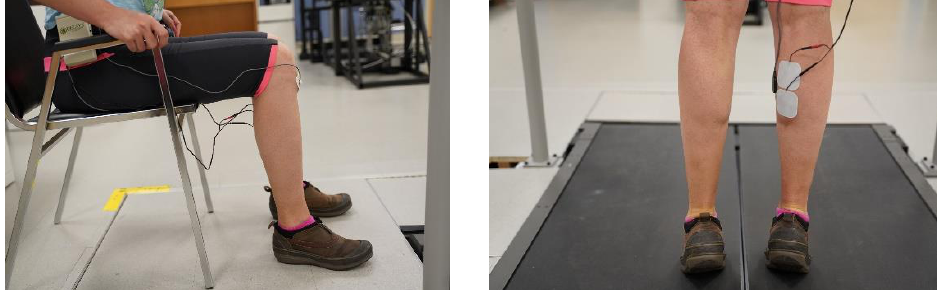
Figure 2. ( Left ): Drift test—participants spent 5 min in a seated position with knees flexed at 90 degrees and were instructed not to move. ( Right ): Lag test—participants performed heel rises to match a metronome at 45, 60, 75, and 90 BPM for 30 s.